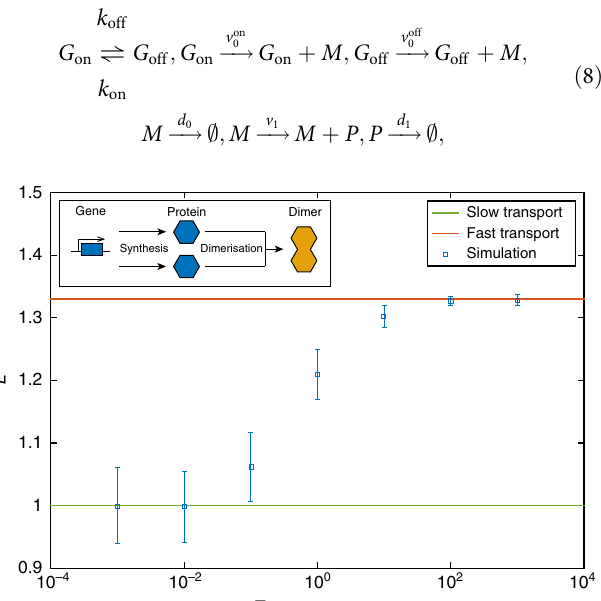
Fig. 4 L as a function of protein transport rate for the three-stage gene expression system (8). Theoretical values for the fast transport limit (red), and slow transport limit (green) are shown as solid lines. Simulation data is shown for the average single-cell variability (blue squares) for a variety of protein transport rates. Parameter values are k on = 0.1, k off = 0.1, v